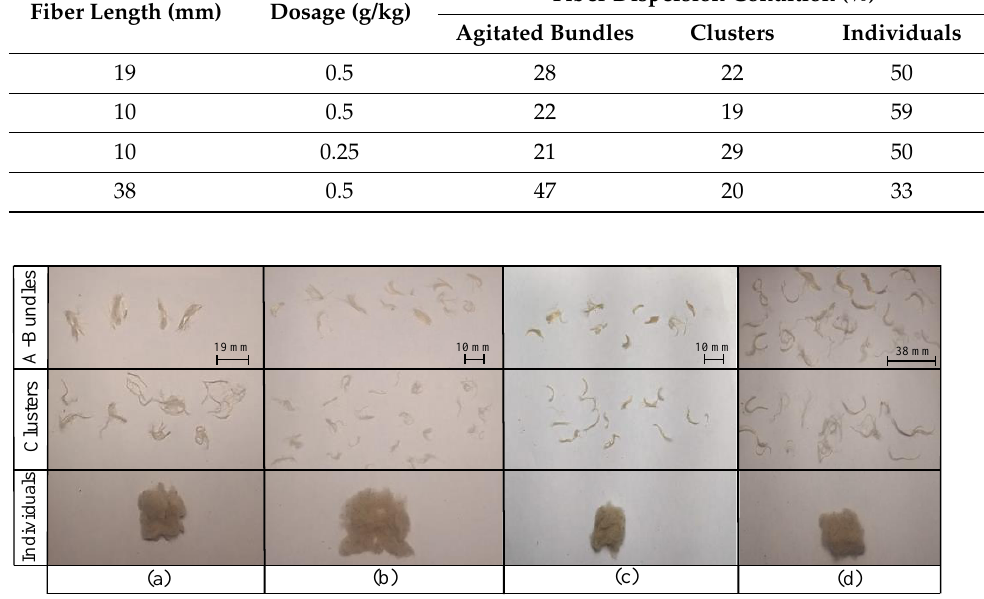
Table 3. Relative percentages of the different fiber dispersion categories by weight after extraction and recovery for the different length and dosage combinations.